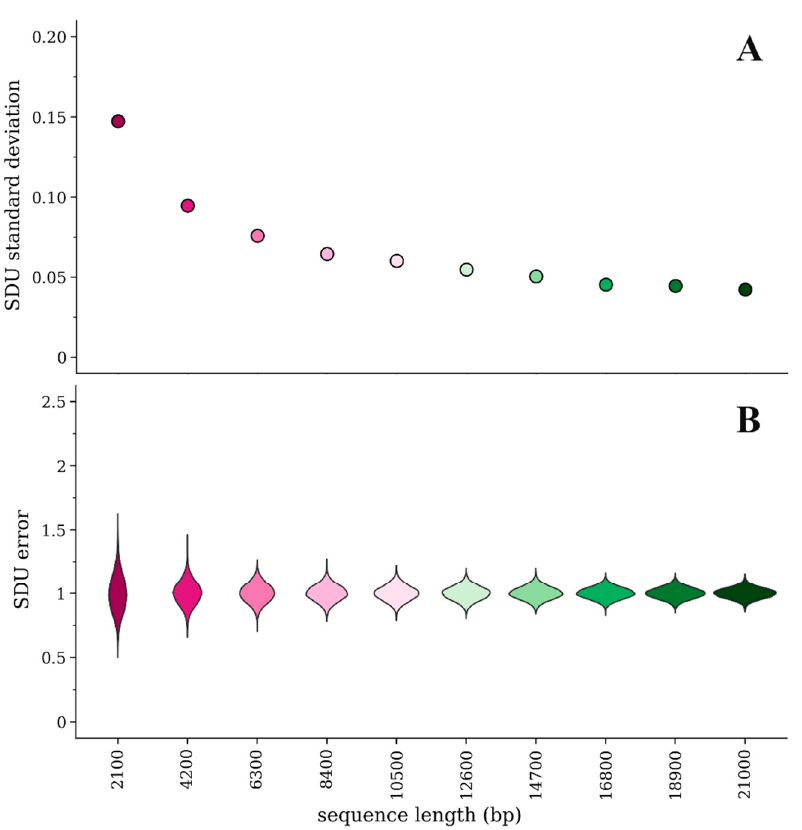
Figure 1. Comparison of error for the SDU CpGbridge of 10 simulated amino acid sequences of different lengths with 1000 random samples of nucleotide sequences for each amino acid sequence: ( A ) Standard deviation of the mean of the SDU error distributions; ( B ) Violin plots of the error distribution for each simulated sequence.